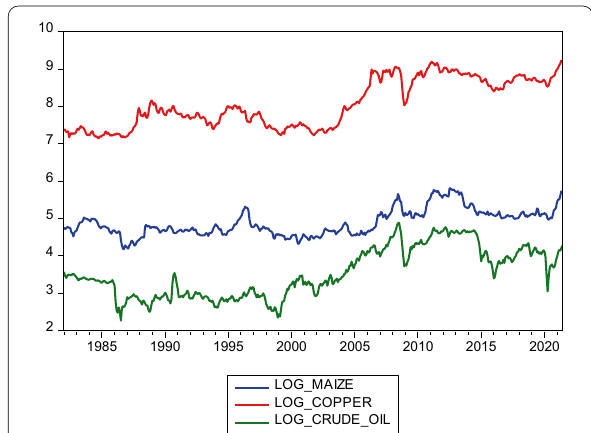
Table 2 Descriptive statistics 2000 to 2021